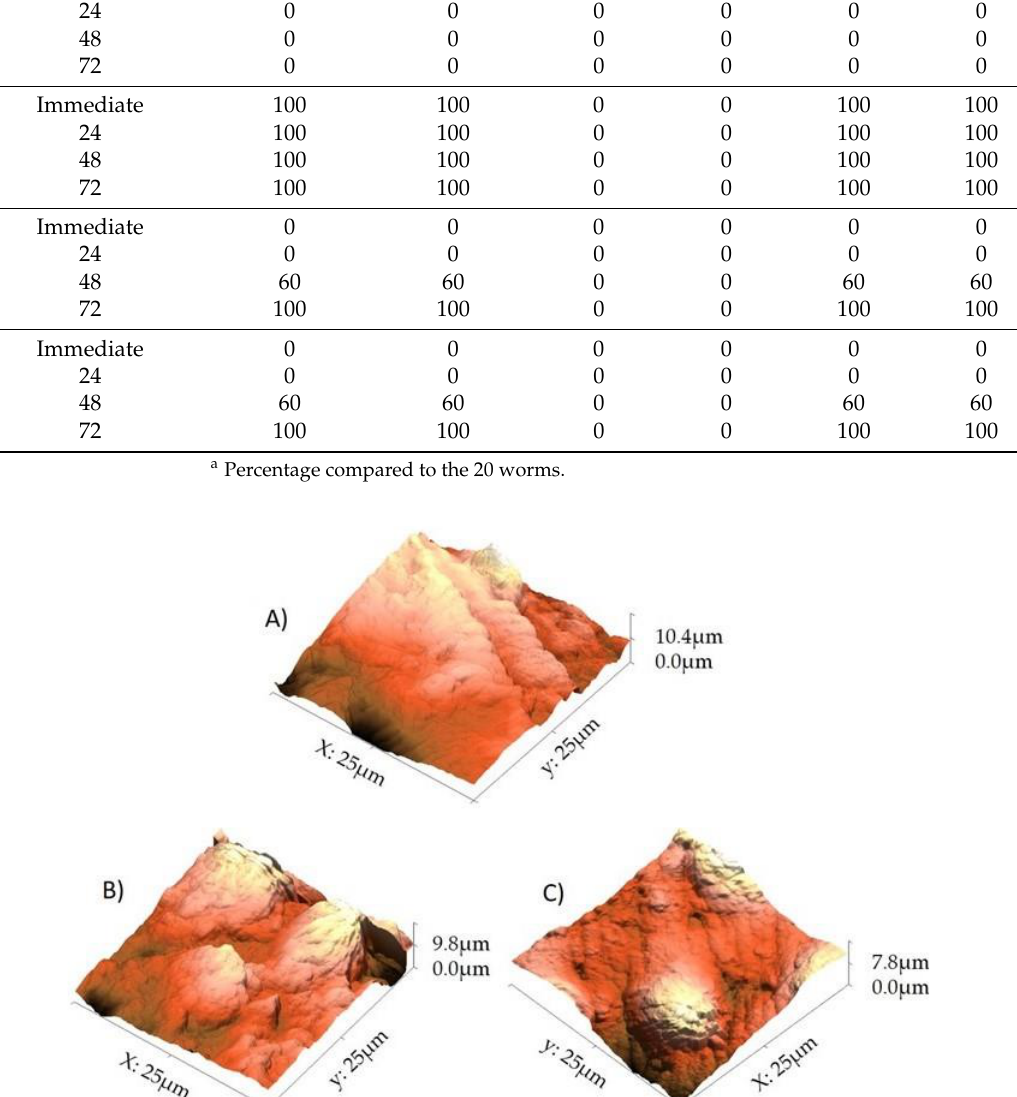
Figure 6. Median roughness tegument of S. mansoni treated with EAE and AE by AFM technique. ** p < 0.05 in relation to control group (untreated). 4. Discussion Montrichardia linifera presented different metabolic pathways originating from sev- eral types of compounds. However, studies in the literature are found reporting the pres- ence of alkaloids and triterpenoids in M. linifera extracts [7]. According to [30], plant secondary metabolites may show considerable variation ac- cording to different factors, such as seasonality, circadian rhythm and development, tem- perature, hydric availability, nutrients, altitude, atmospheric pollution, and induction by mechanical stimuli or pathogens. These factors may explain the differences found in the tests performed in the present study and the results reported in the literature. Among the compounds studied, flavonoids have stood out due to their wide range of biological and therapeutic activities, demonstrated in vitro and even in humans [31].